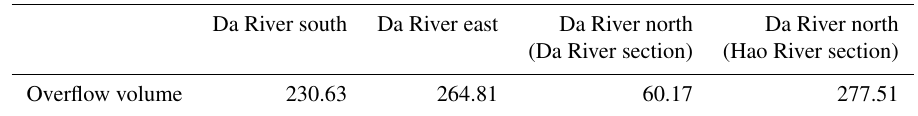
Figure 3. Distribution of hourly water levels at hydrological stations. (The time of water level data are from 00:00 on 15 August to 00:00 on 23 August 2014 (UTC + 8h).) Table 1. Overflow volume of Liandu district in 2014 based on the hydraulic model (10000m 3